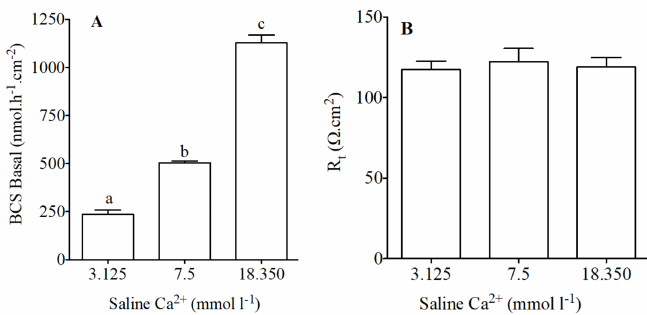
Figure 3. HCO 3 − secretion (nmol · h − 1 · cm − 2 ) as measured in Ussing chambers by pH-Stat ( A ) and tissue resistance (Rt, Ω · cm 2 ); ( B ) in preparations from the anterior intestine of juvenile sea bream with an apical saline 3.125, 7.5 and 18.350 mmol · L − 1 Ca 2+ . Each bar represents the mean ± SEM ( n = 4–6).